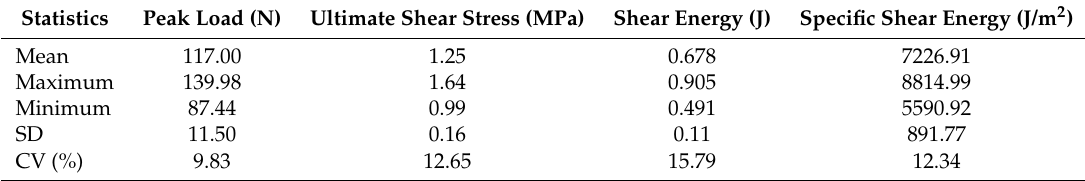
Table 5. Results for 20 aubergine peduncles tested with the straight